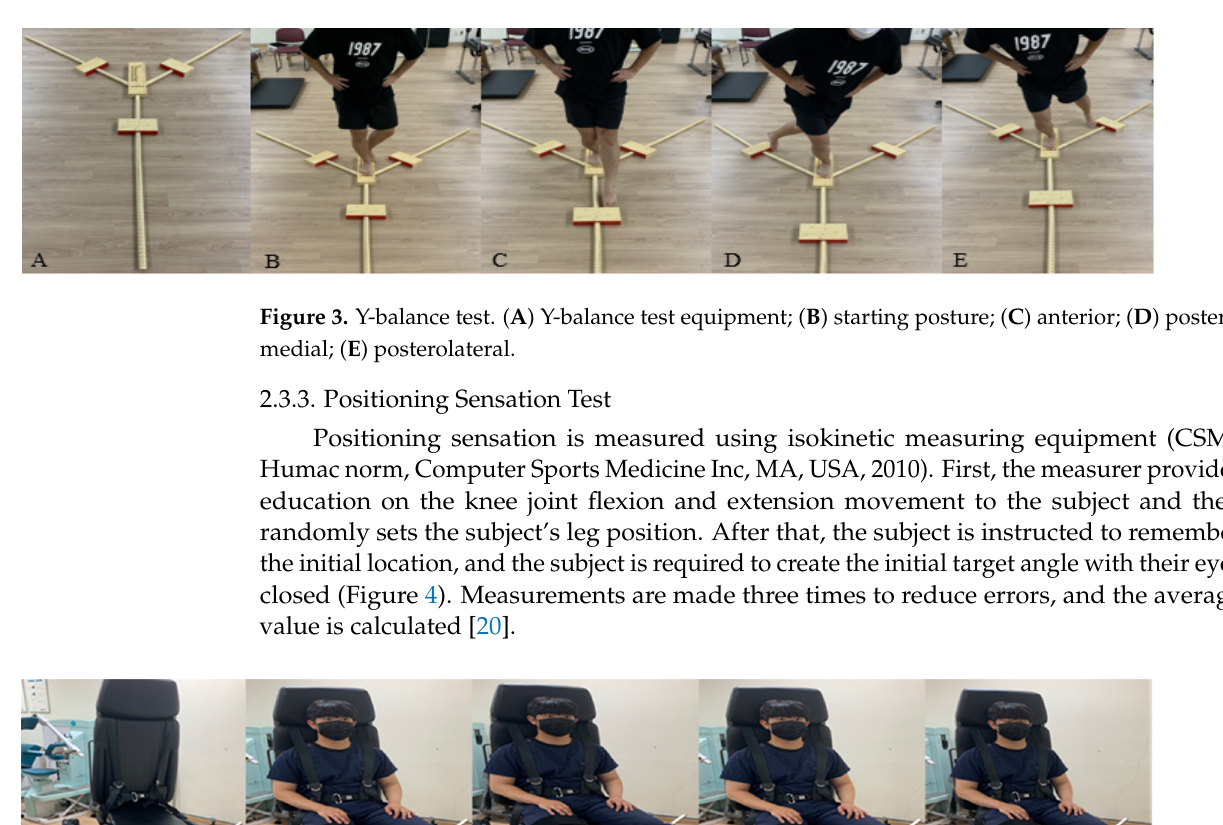
Figure 3. Y-balance test. ( A ) Y-balance test equipment; ( B ) starting posture; ( C ) anterior; ( D ) poster- omedial; ( E ) posterolateral.